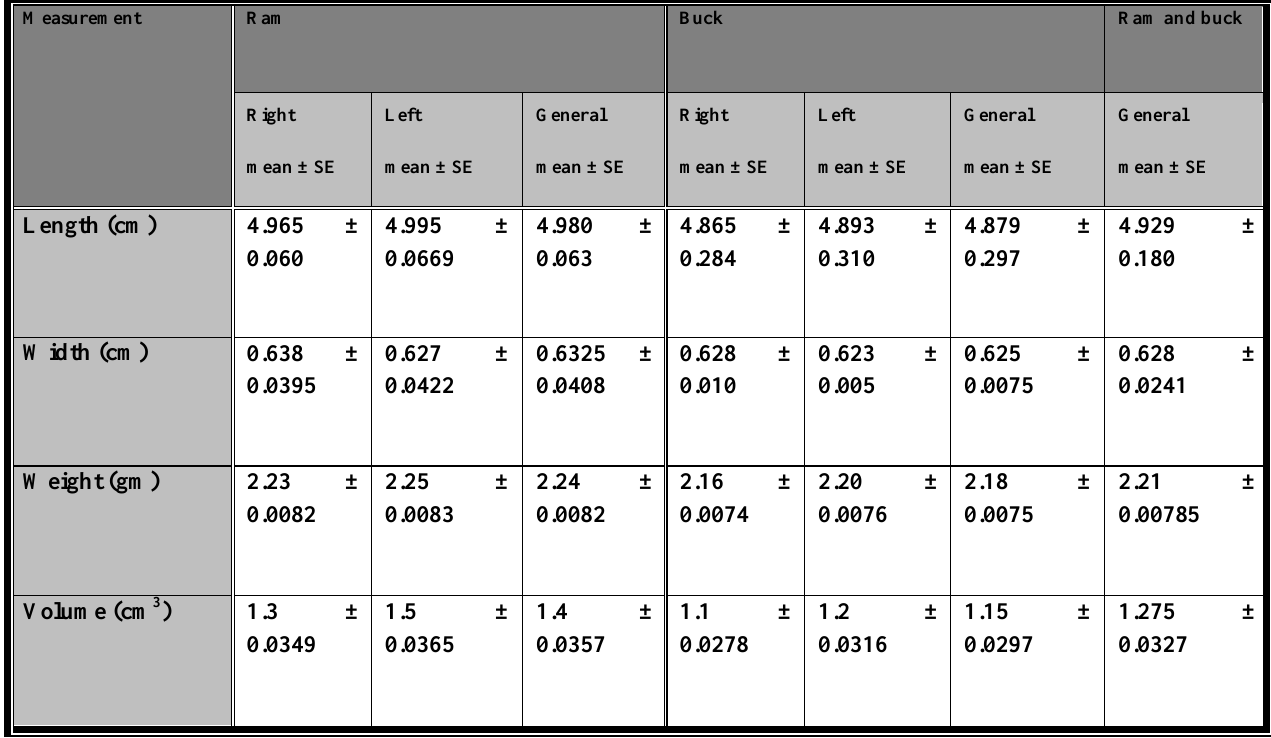
Table 1: Anatomical parameter of ampullae in ram and buck. Measurement